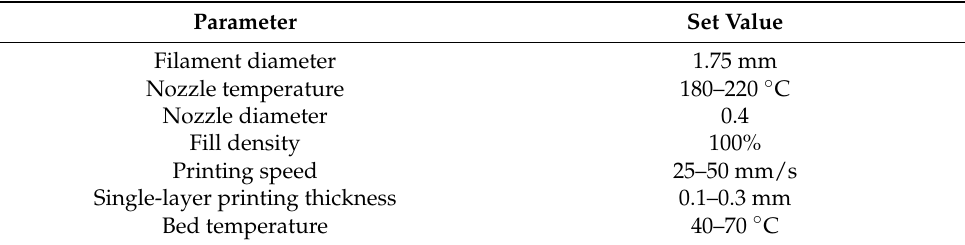
Table 1. Set 3D printer